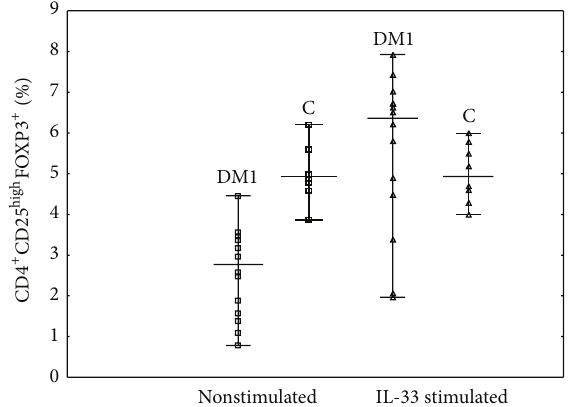
Figure 2: Quantitative characteristics of CD 4 + CD 25 high FOXP 3 +